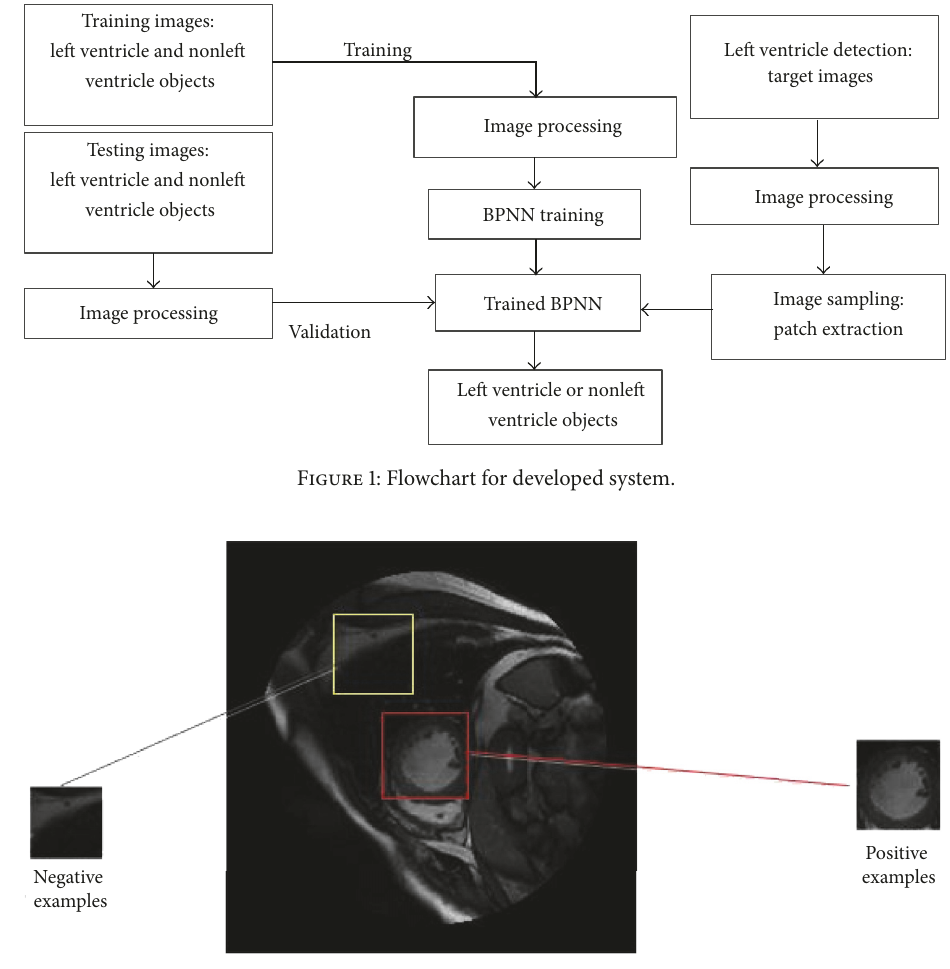
Figure 2: Positive and negative examples extraction from the MR